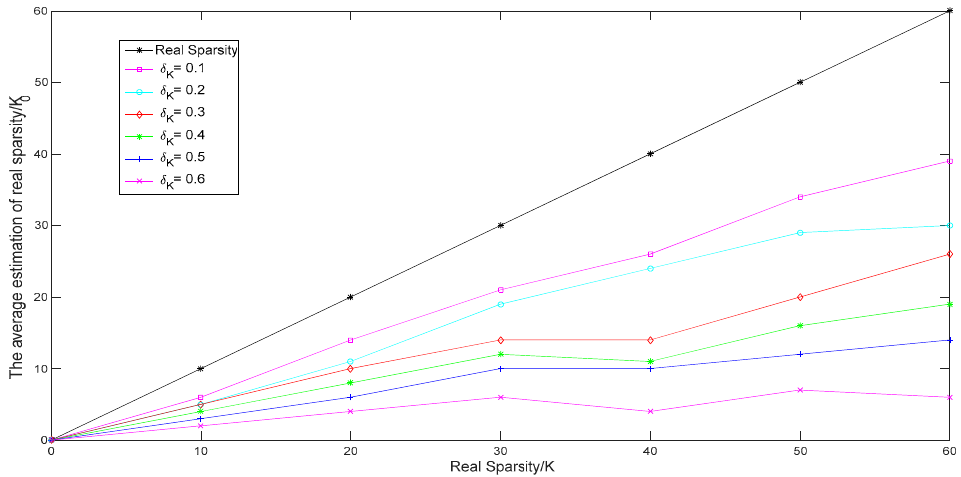
Figure 4. The average estimated sparsity of different isometry constants with different sparsities ( n = 400, δ K ∈ [ 0.1,0.2,0.3,0.4,0.5,0.6 ] and m = 170, Gaussian